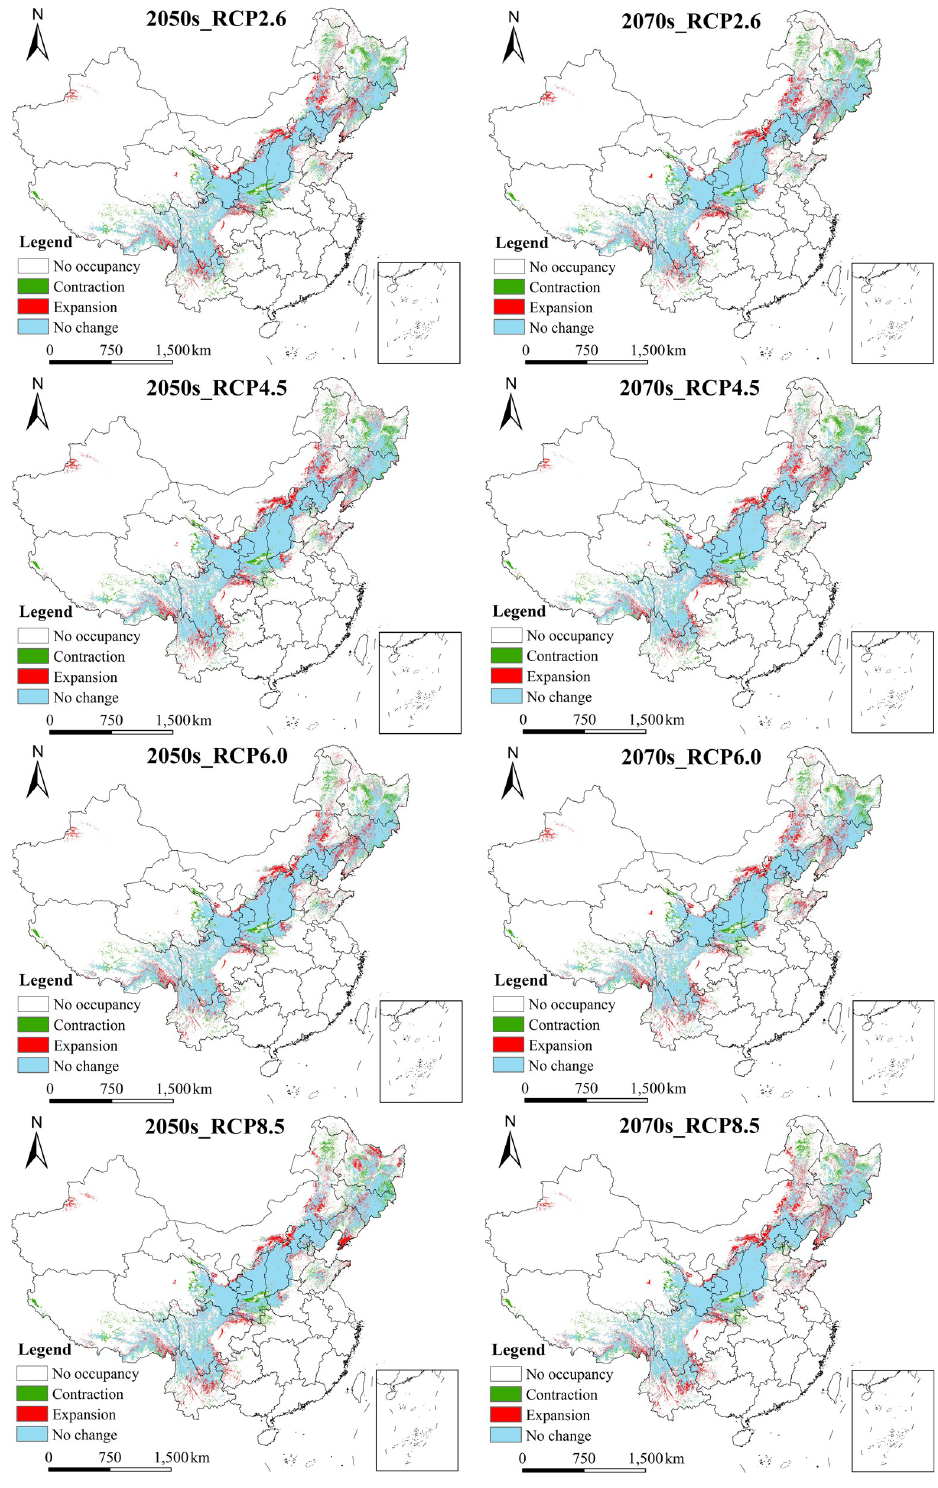
Fig 6. Changes of the suitable area of Betula platyphylla Suk. under the four RCPs (RCP2.6, RCP4.5, RCP6.0, and RCP8.5) in the Two Periods (the 2050s and 2070s), compared with the current potential geographic distribution. The boundary was obtained from Natural Earth (http://www.naturalearthdata.com/). Based on the principle of national and territorial integrity, we have modified and adjusted the vector boundary.